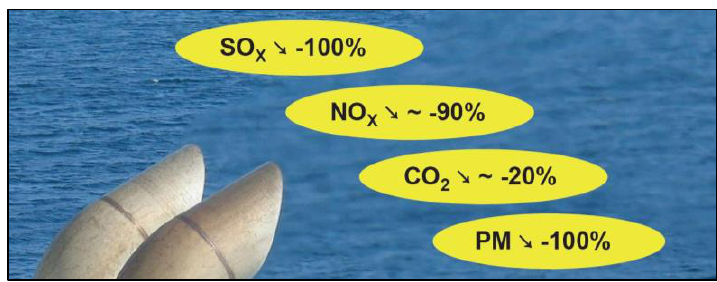
Figure 10: Effects on emissions when using LNG as